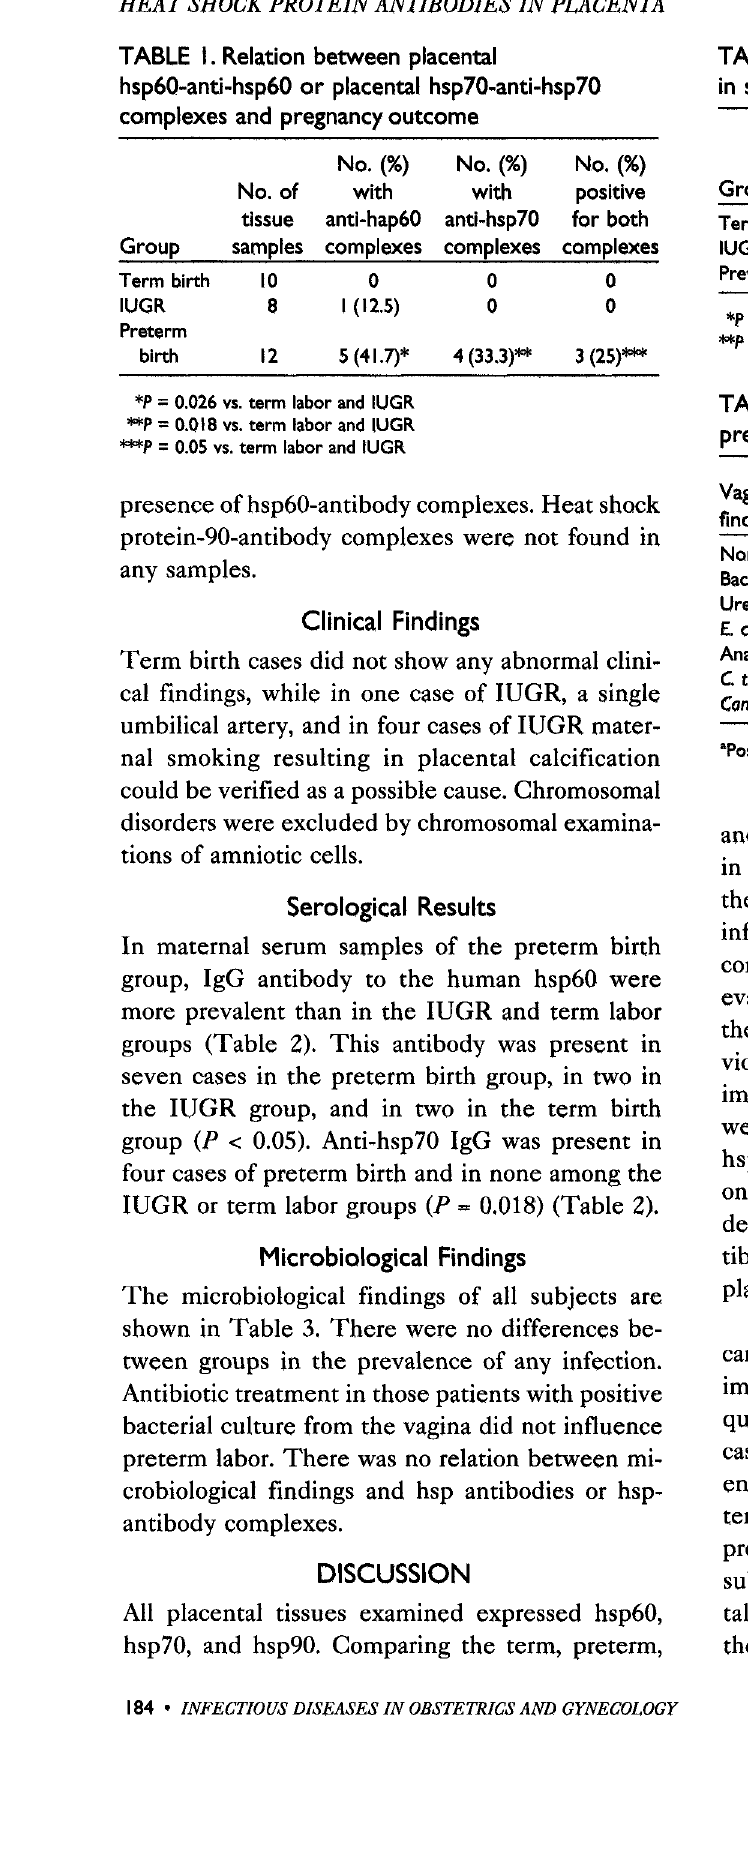
*P 0.026 vs. term labor and IUGR **P 0.0t8 vs. term labor and !UGR ***P 0.05 vs. term labor and IUGR presence of hsp60-antibody complexes. Heat shock protein-90-antibody complexes were not found in any samples.